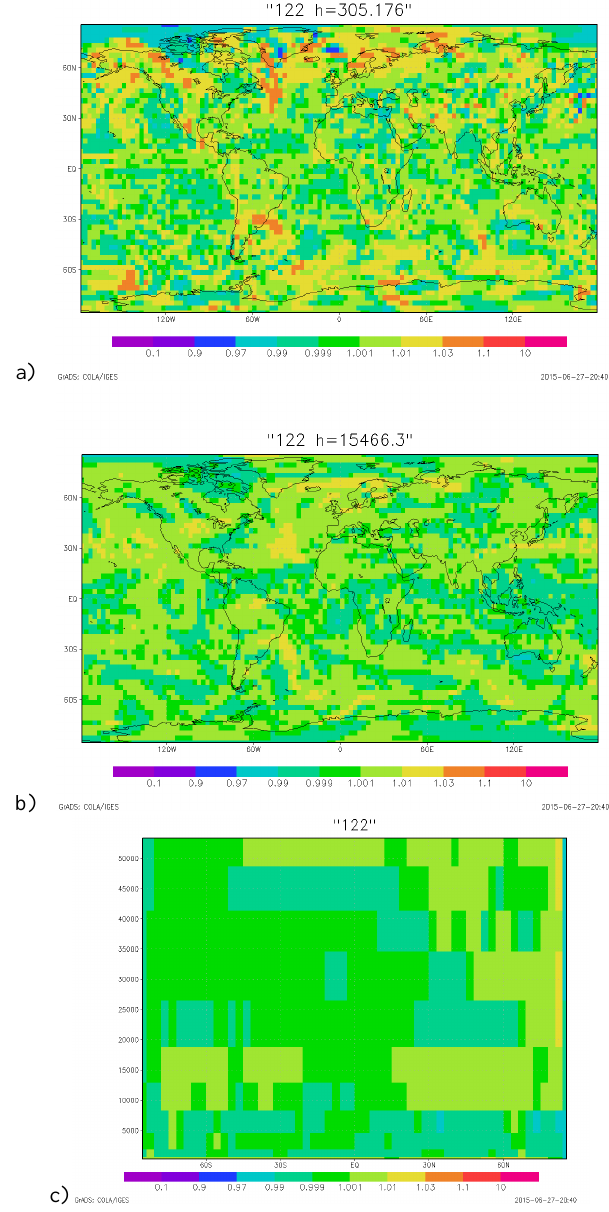
Figure 15. Constant-vmr test with real-wind conditions after 122h. (a) vmr within the boundary layer, (b) vmr above the tropopause, and (c) zone-average vertical cross section of vmr. Without